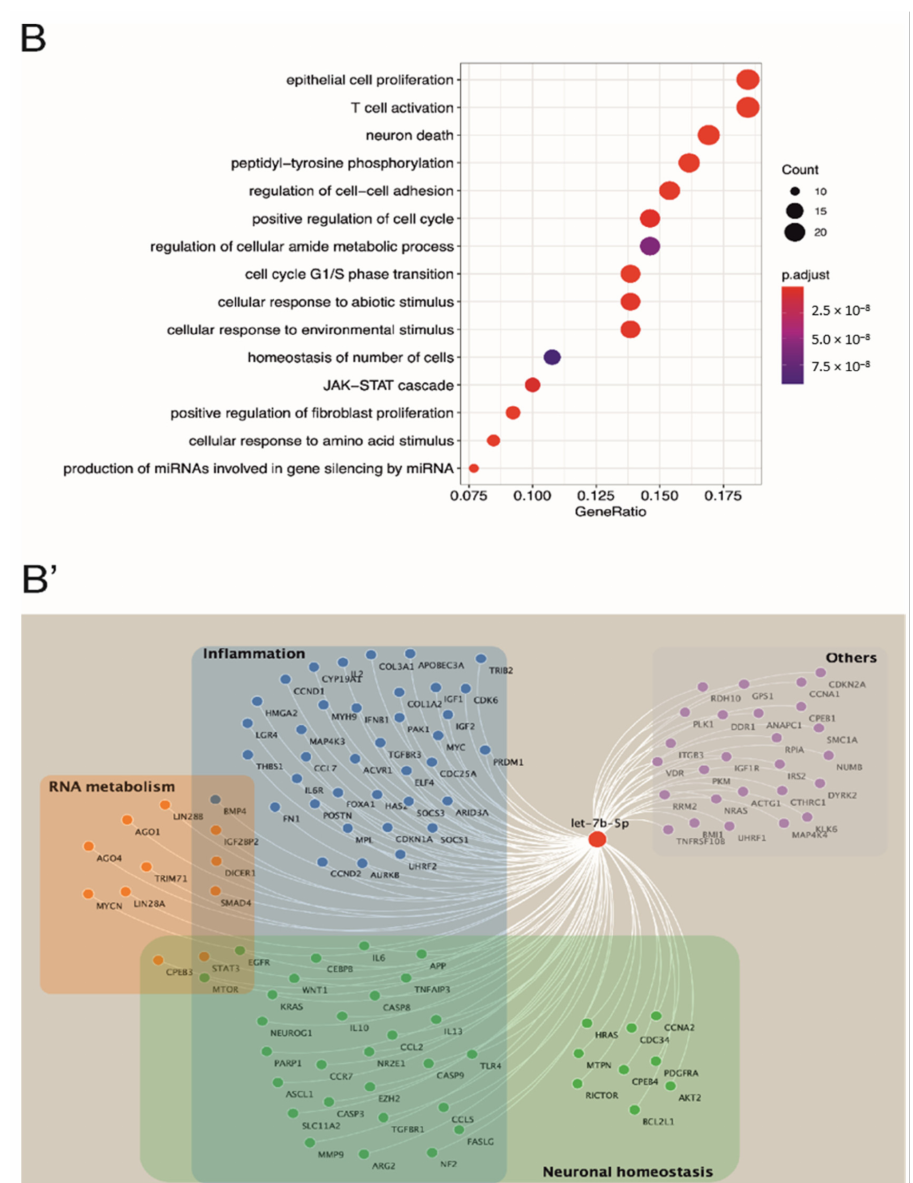
Figure 1. Let-7 family is a good candidate as a MS-associated miRNA. ( A ) DNA sequences alignment of the mature miRNAs part of the let-7 family. In black the nucleotides positions conserved among all members of the let-7 family. The seed sequence is indicated as a red box. ( A’ ) Genomic organization of let-7 family genes in humans. Gene clusters are divided according to the genome organization (intronic or intergenic). Chromosome strands are indicated by (+) or ( − ). Figure information sourced from http://microrna.sanger.ac.uk/sequences/. ( B ) Functional analysis of experimentally validated target mRNAs of let-7 obtained from miRTarBase (http://mirtarbase.cuhk.edu.cn/php/index.php). The most represented Gene Ontology categories for target mRNAs are reported in the figure. Size dots are correlated with the number of genes that belong to a Gene Ontology category and dots are colored according to the Benjamini-Hochberg false discovery rate adjusted p -values from blue (higher p -adjusted) to red (lower p -adjusted). ( B’ ) Network of let-7 targets that can be ascribed to three main processes involved in MS pathophysiology: inflammation (light blue rectangle); neuronal homeostasis (green rectangle); RNA metabolism (orange rectangle). Target mRNAs of let-7 involved in more than one process are represented into the rectangle overlapping zones. Targets participating in other pathways are grouped into a light violet rectangle (26 out of